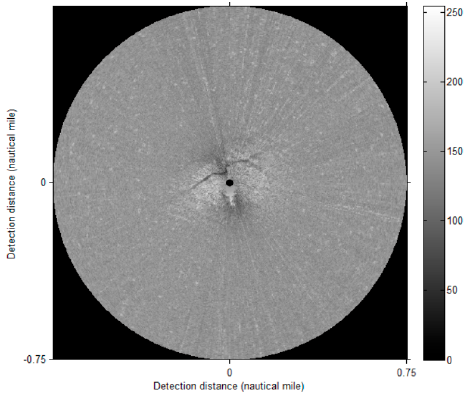
Figure 11. Data pre-processing result of Figure 3a.